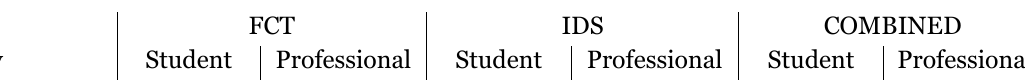
MOOC Participant Motivations, by Current Status FCT